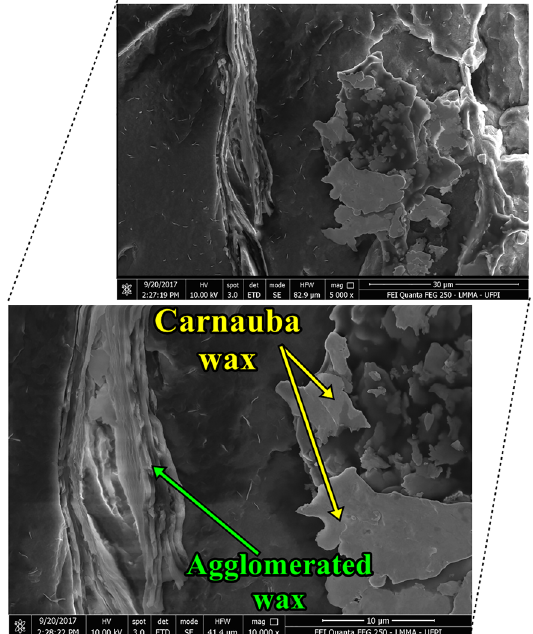
Figure 9. Scanning electron microscopy of the fracture surface of PBAT/SR/CW - 5.0 with a magnification of 10000x (colored